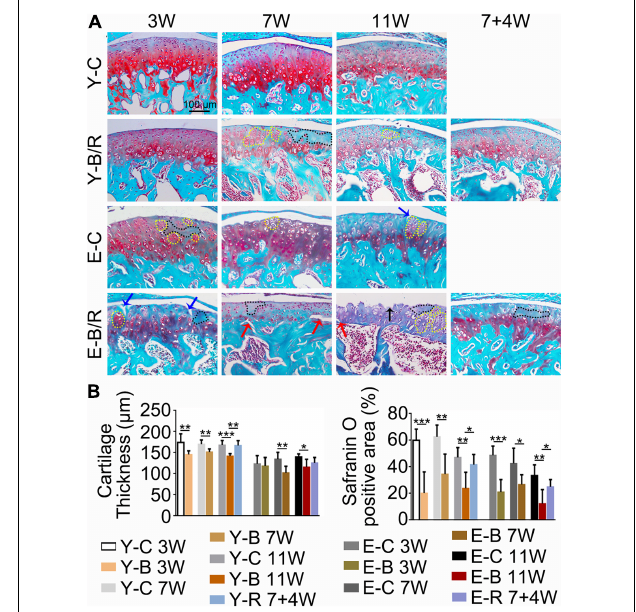
FIGURE 6 | (A) Representative hematoxylin and eosin (HE) staining. The black arrow indicates the serrated injury at the surface of the cartilage. The blue arrows indicate the fissures at the surface of cartilage. The red arrows indicate the fissures between cartilage and subchondral bone. Cell-free areas are obvious in the E-B/R groups. Bars = 100 µ m. (B) Comparison of the OARSI grade between the groups. Data are presented as mean ± SD. Unpaired t -test was used for comparisons between the age-matched control and BAC groups. One-way ANOVA was used for comparisons among the age-matched control, BAC, and BAC removal groups. n = 6. * P < 0.05; ** P < 0.01 and *** P < 0.001 for the differences between all BAC and removal groups and the age-matched control groups. For grouping and time points, please refer to Figure 1A . elder control groups was relatively dense with fewer fissures.